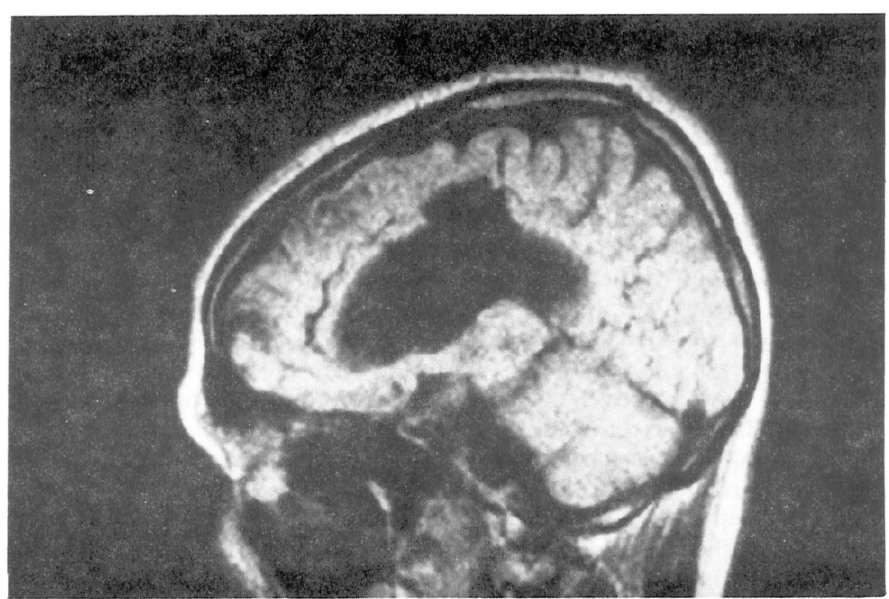
FIG. I. MRI image ofsagitai section 10 mm right from the midline (15 Oct., 1986). Range of callosal lesion is well